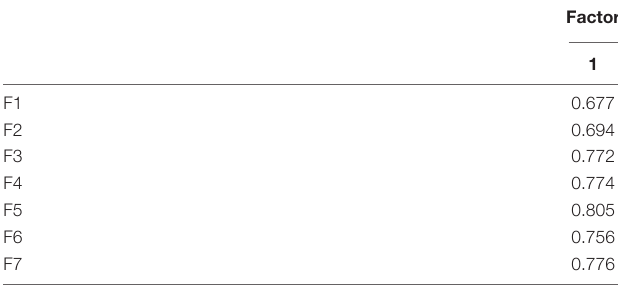
TABLE 2 | Pattern matrix of the FCV19.